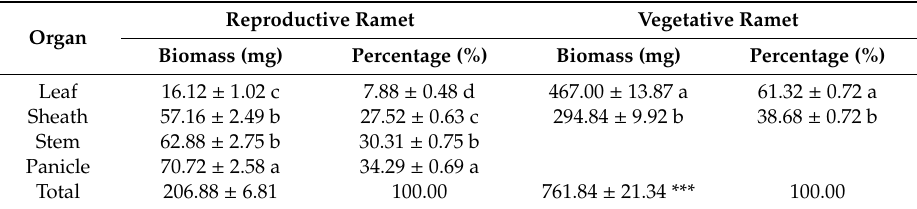
Table 2. Mean biomass allocation to various organs of reproductive ramets and vegetative ramets in the natural populations of Hierochloe glabra (data are represented as the means ± standard errors, n = 25). Reproductive Ramet Vegetative Ramet Organ